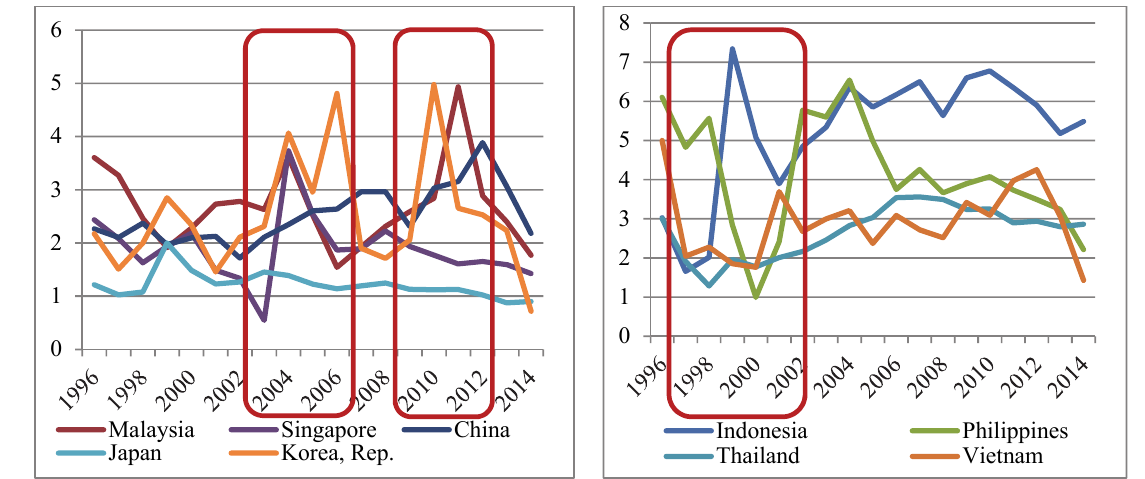
Fig. 6. Net interest margin in more developed systems (%) Fig. 7. Net interest margin in less developed systems (%) Data source: World Bank Global Financial Development